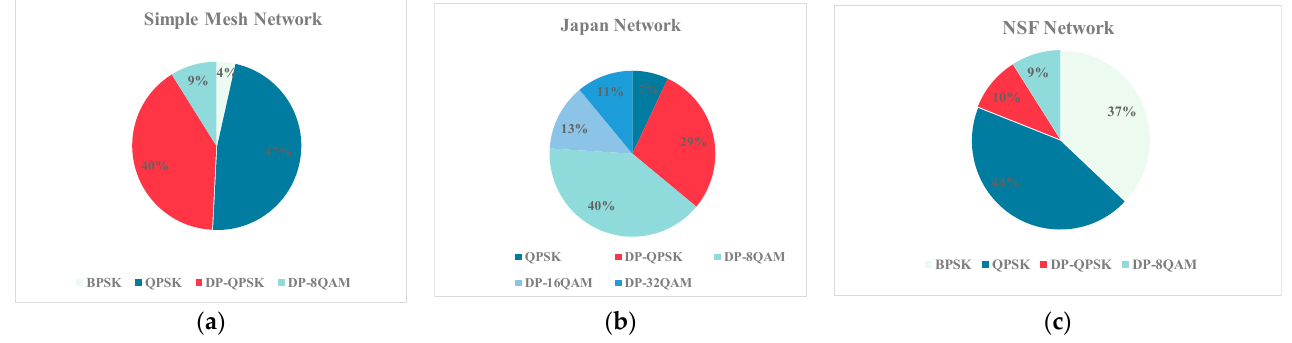
Figure 7. ( a ) Utilization of the modulation formats in the simple mesh network; ( b ) Utilization of the modulation formats in the Japan network; ( c ) Utilization of the modulation formats in the NSF network.